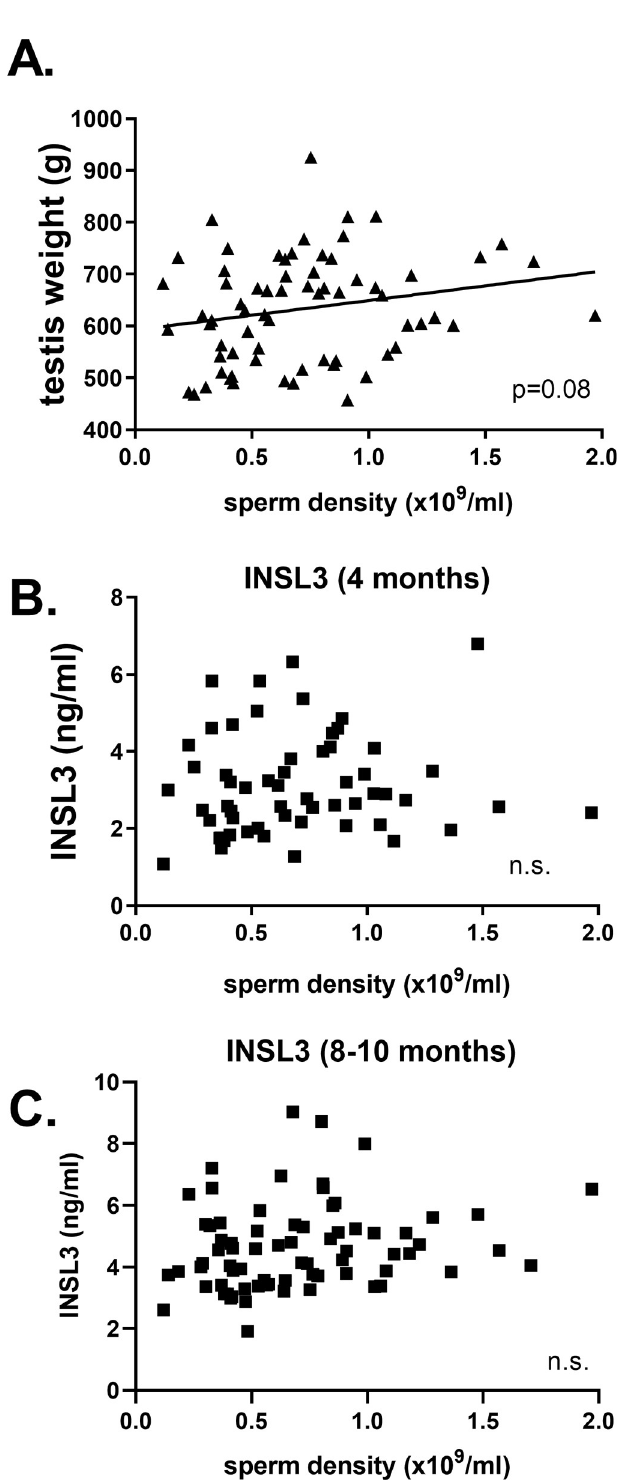
Fig 4. Regressions of average sperm density against (A) paired testis weight at slaughter (18 months), (B) INSL3 concentration at 4 months, and (C) average INSL3 concentration at 8–10 months) . Probability of a significant regression is indicated as p value, or n.s. (not